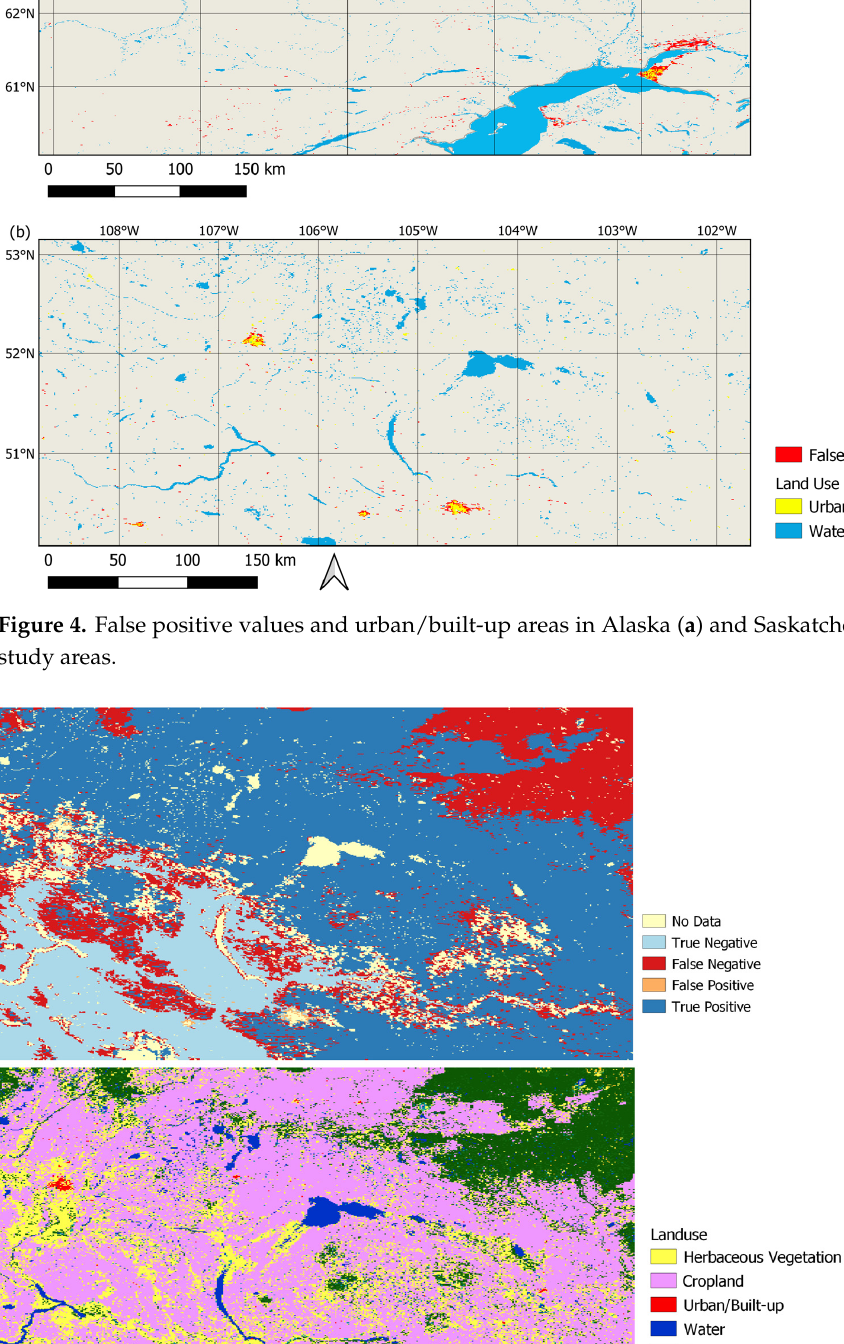
Figure 5. Map of the confusion matrix for the Saskatchewan case study area ( top ) and land use for